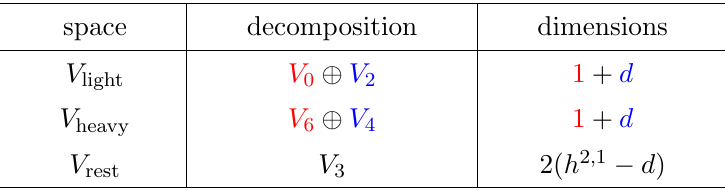
Table 3 . Decomposition of H 3 ( Y 3 ; R ) for IV d . Note that we have used di(cid:11)erent colors to indicate the dimensions of the individual